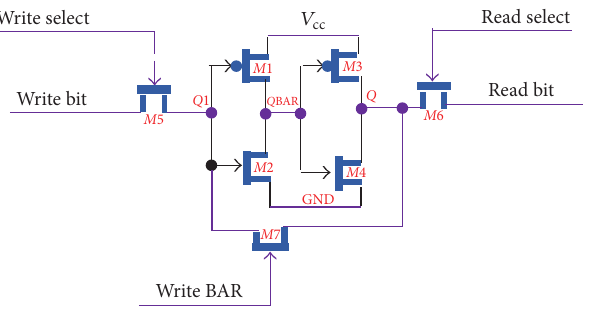
Figure 7: 6T SRAM structure.